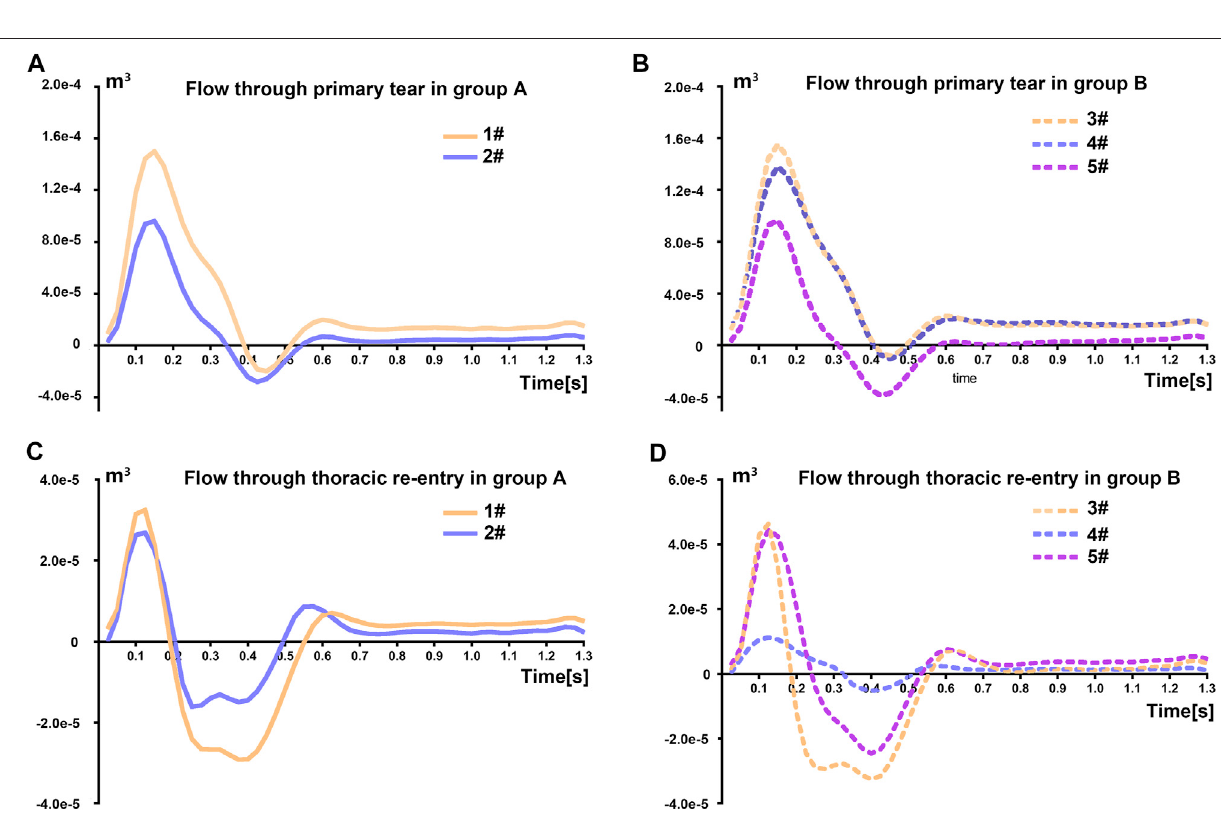
Frontiers in Bioengineering and Biotechnology |